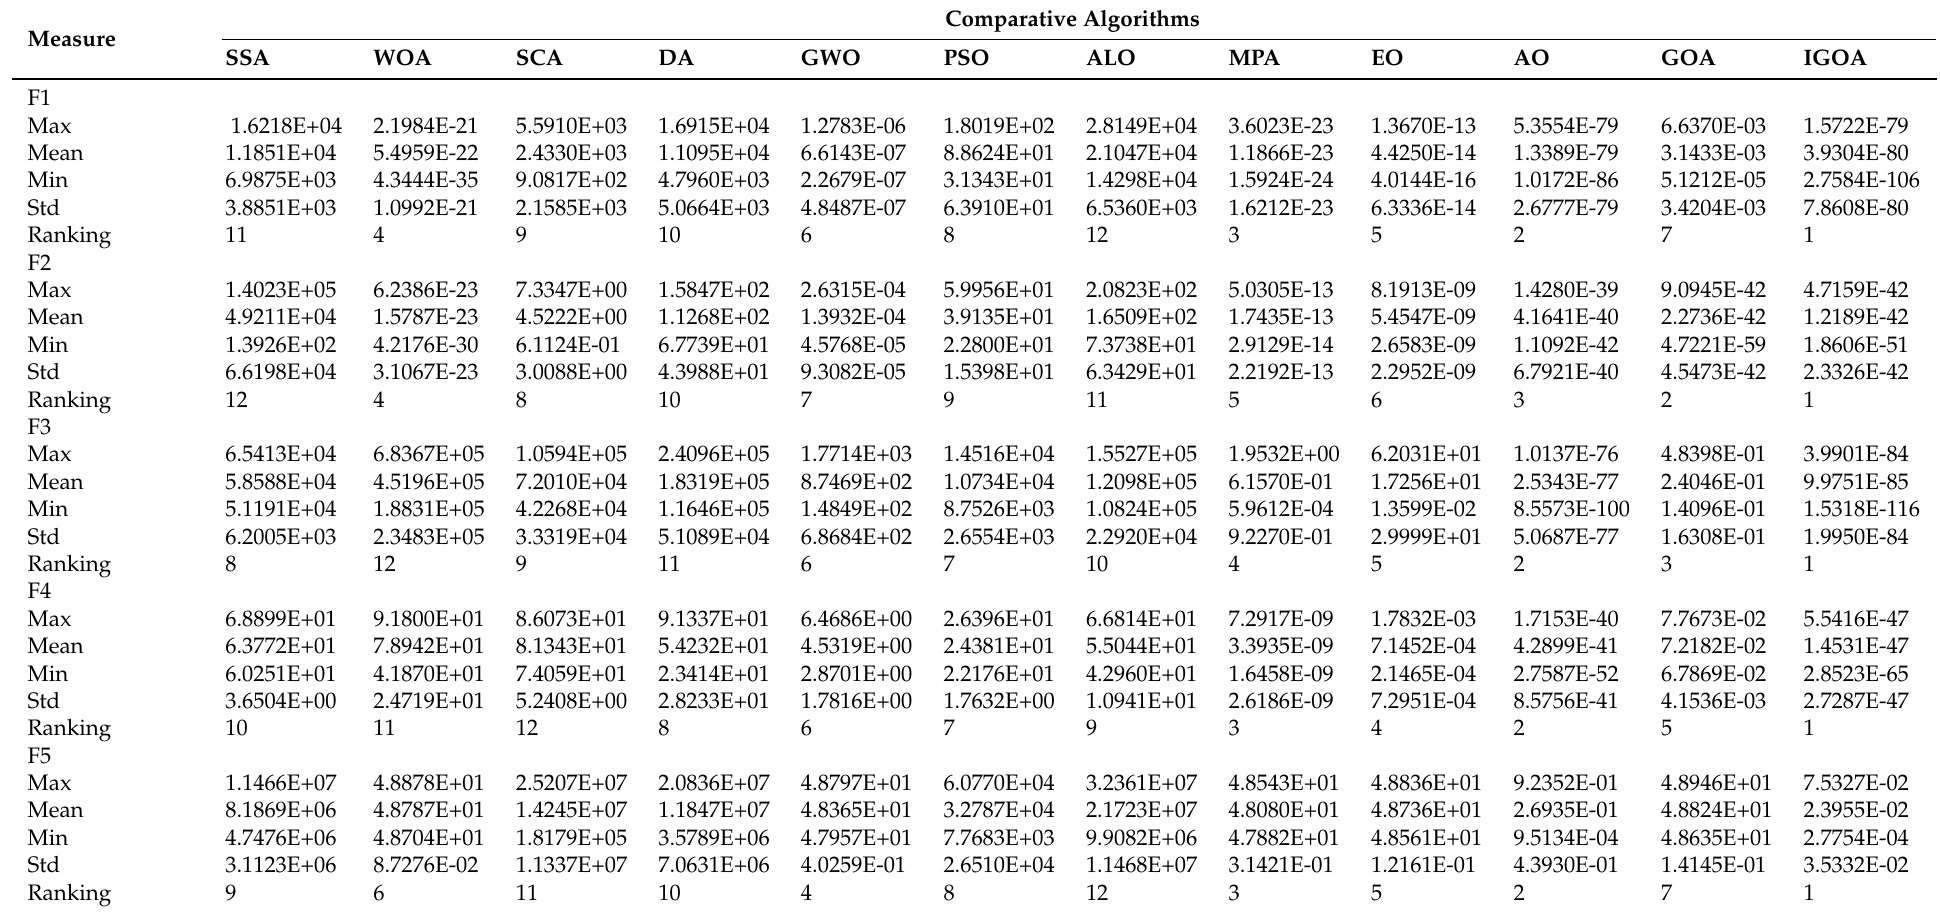
Table 7. The results of the proposed IGOA and other comparative methods using classical benchmark functions (F1–F13), where the dimension size is